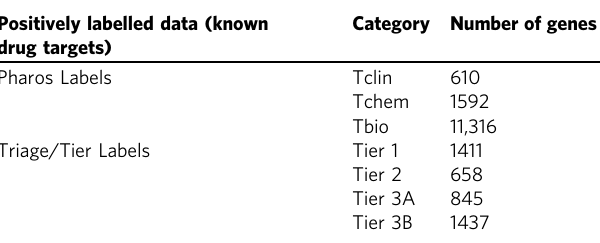
Table 1 Resources for extracting labels around the druggability potential of genes, based on varying levels of supporting